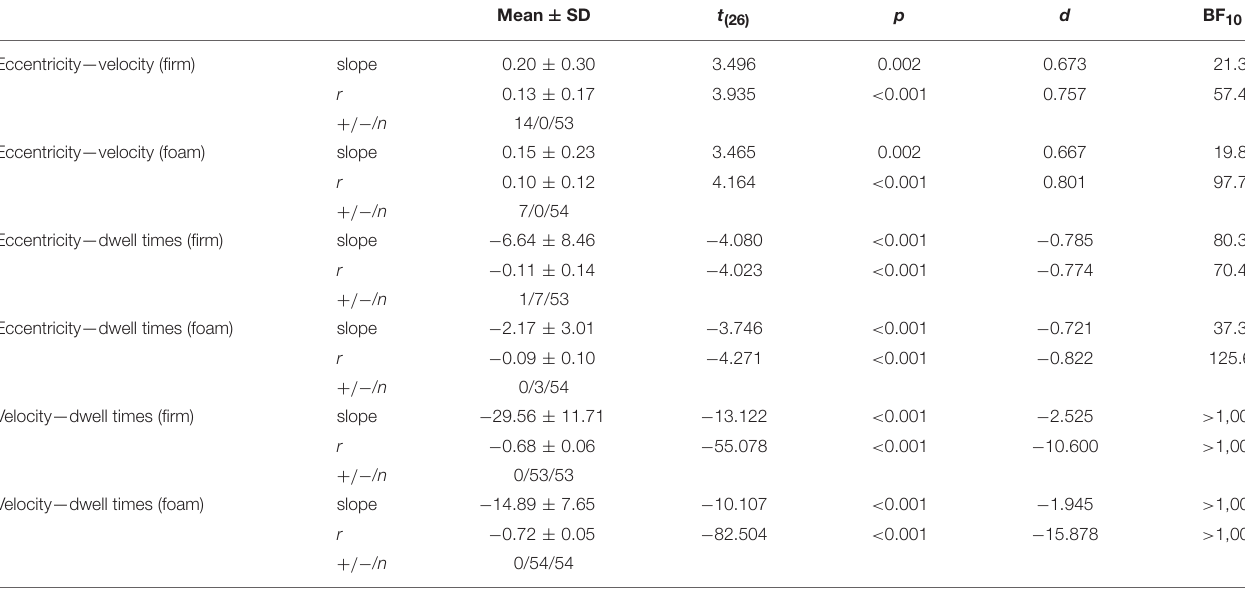
TABLE 1 | Mean slopes (slope), Pearson correlation coefficients ( r ), and their standard deviations (SD) as well as the number of significant positive ( + ) and negative (-) correlations of all trials n among local eccentricity, local velocity and local dwell times, separately for firm and foam